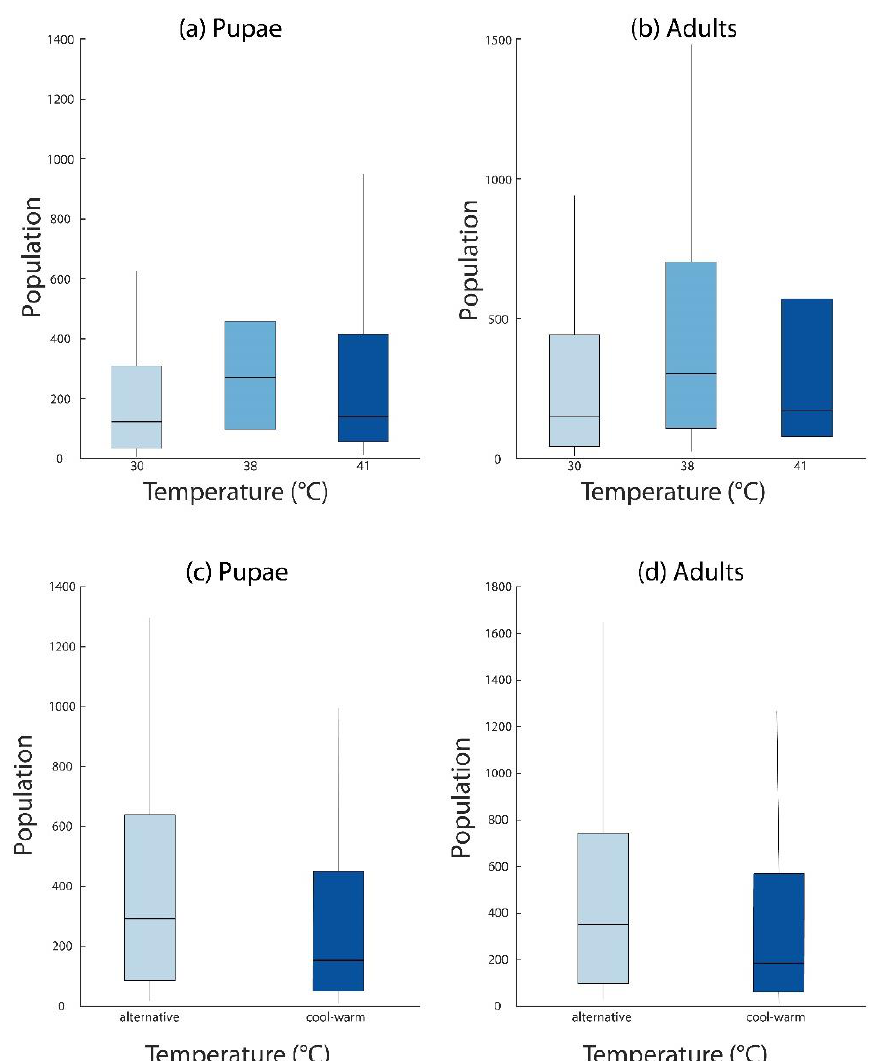
Figure 4. Population modeling based on changes in pregnancy duration following feeding. ( a , b